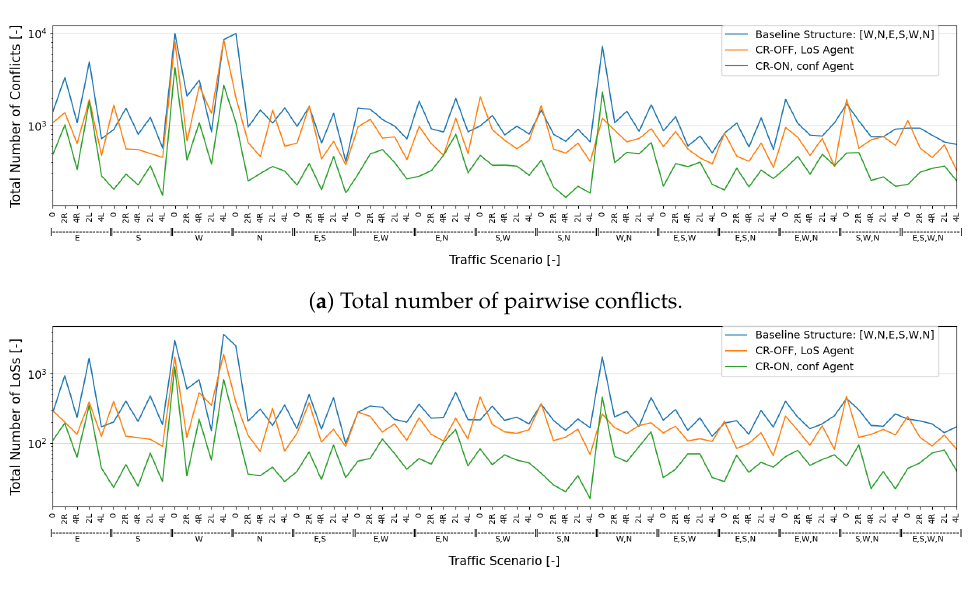
Figure 13. Final comparison of the best RL agents during training in an environment with conflict resolution. The results are directly compared using a baseline, fixed